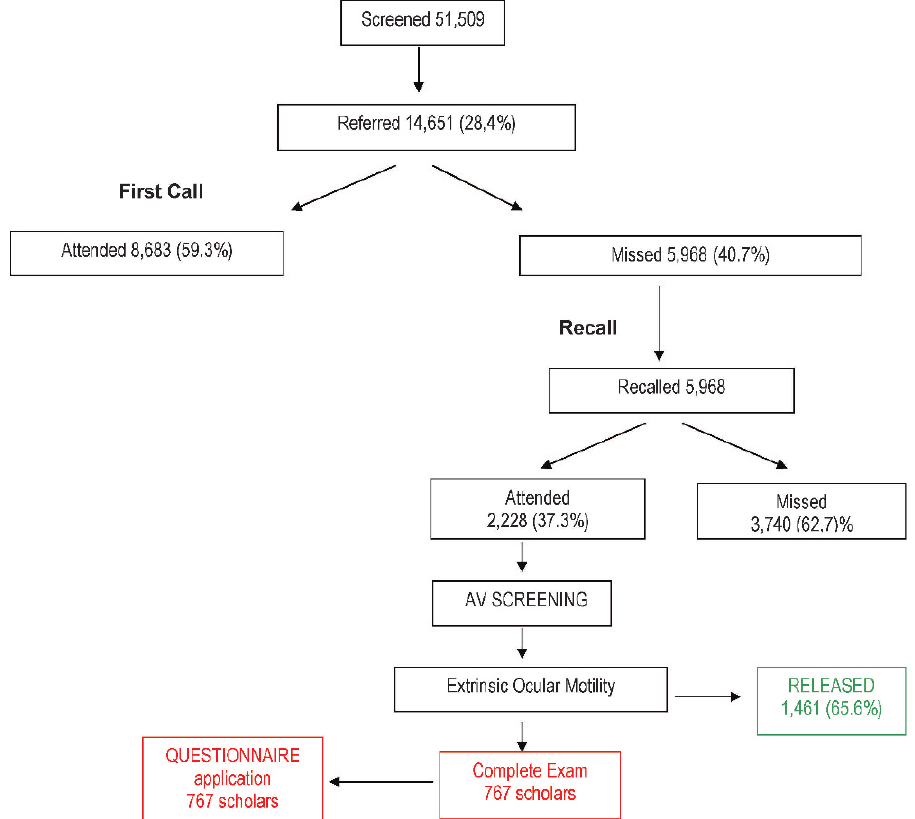
Figure 1 - Flow chart of the Eye-to-Eye Campaign attendance – Guarulhos